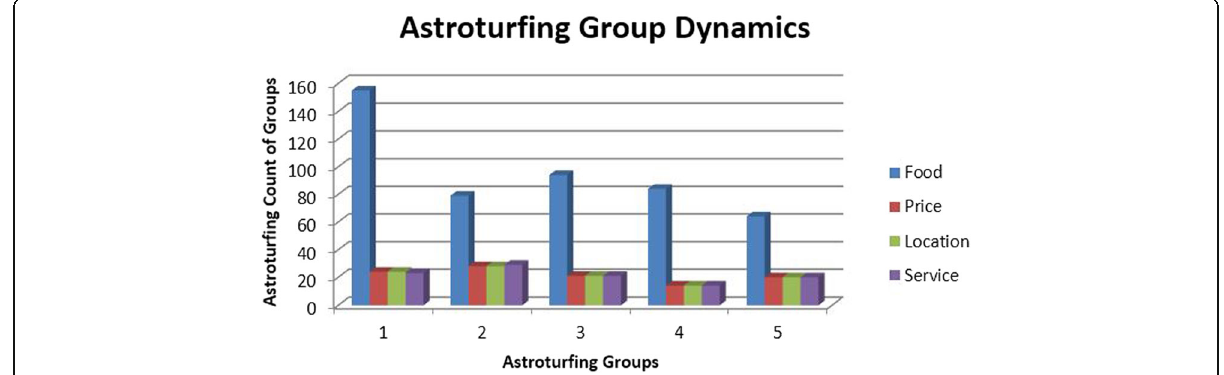
Fig. 3 Latent astroturfing group